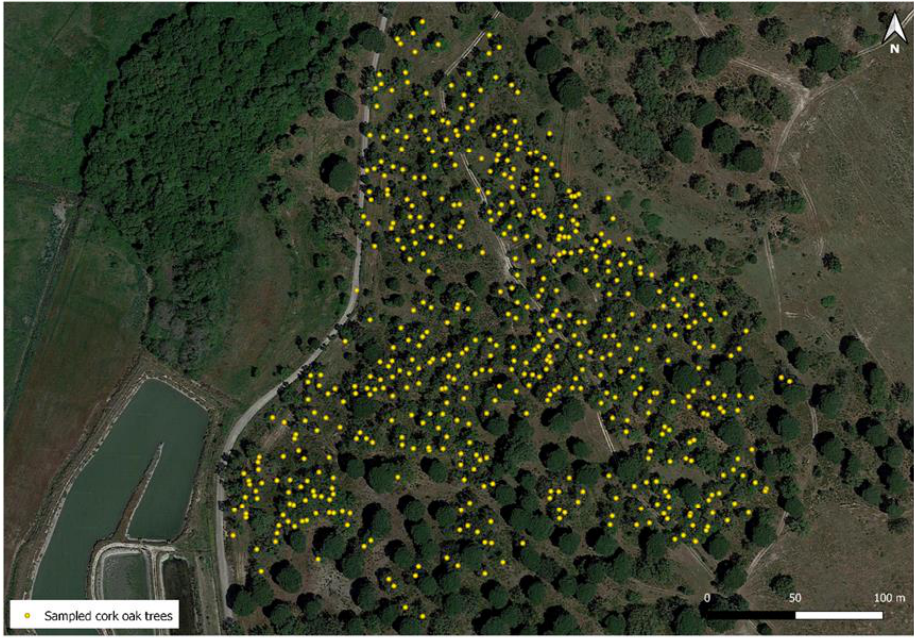
Figure 1. Map of the cork oak population analyzed. The trees included in the study are indicated with a yellow dot. with a yellow